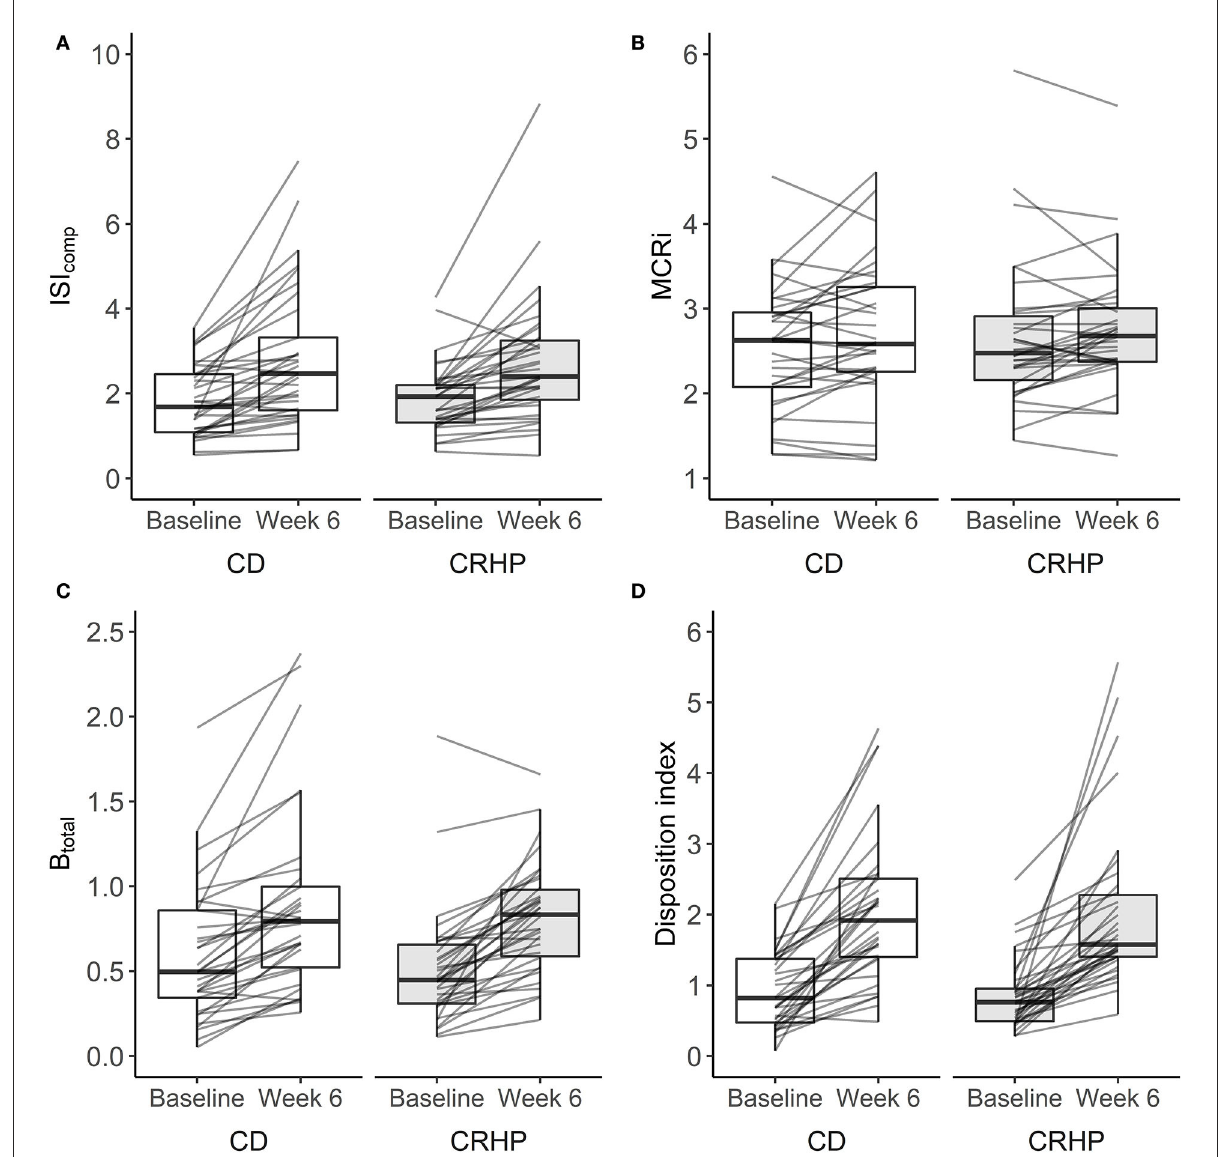
FIGURE2 Changes in the composite index (ISI comp ) (A) , metabolic clearance rate of insulin (MCRi) (B) , β -cell responsiveness to glucose (B total ) (C) , and disposition index (D i ) (D) derived from an OGTT at baseline and after 6 weeks of a CD or CRHP diet. Data are presented as median (25th, 75th) with individual changes. No differences between diets were evident from linear mixed model analysis: P for (A–D) , respectively. Estimates are in units: L 2 x mg − 1 − 2 x min − 1 × µ U − 1 × 10 − 1 (D i